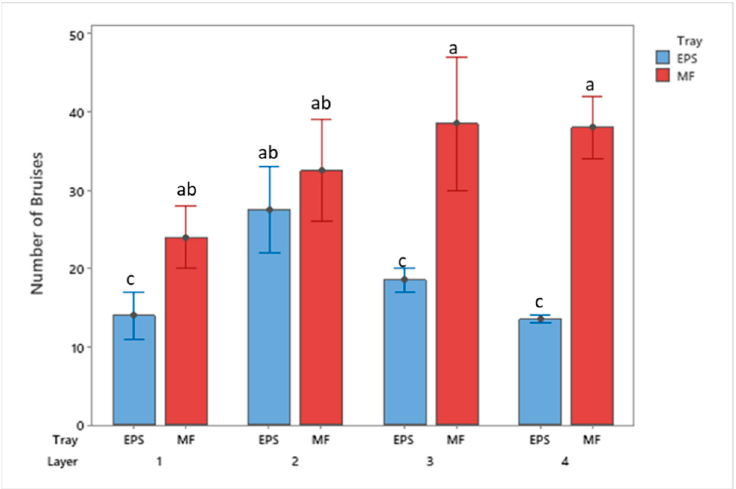
Figure 6. Bruise frequency of apples by tray location packaged using MF and EPS trays from 30 cm drop height (mean ± SD, n = 2). Different letters indicate statistically significant differences at p < 0.05. Bars with no common letters are significantly different ( p < 0.05).